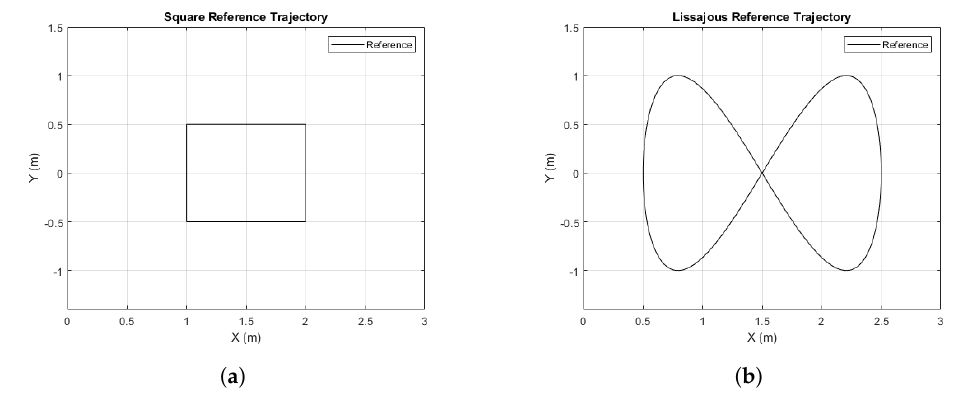
Figure 11. Reference trajectories. ( a ) Square reference. ( b ) Lissajous curve